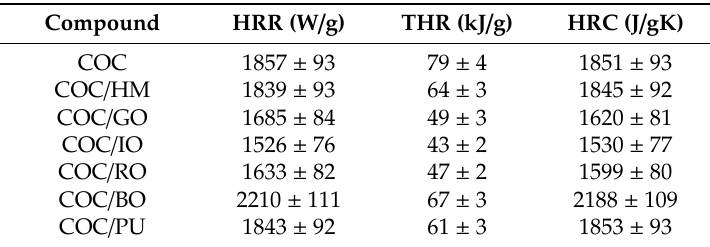
Table 4. Microscale combustion calorimetry analysis